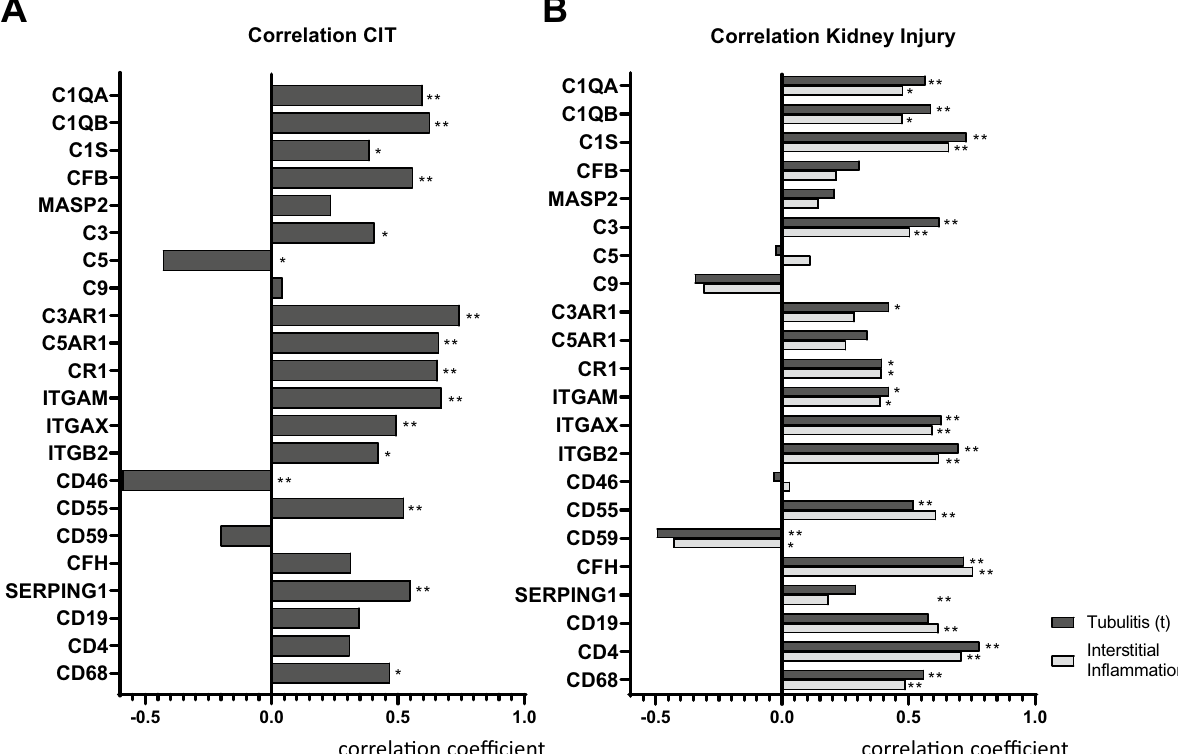
Figure 3. Correlation analysis of complement gene expression with CIT and kidney inflammation in transplant biopsies. Correlation of complement system-associated gene RNA molecule numbers with cold ischemia time during transplantation ( A ) and severity of tubulitis and interstitial inflammation ( B ) in follow-up biopsies; (Statistical analysis: Spearman correlation test, *p < 0.05; **p < 0.01); n =